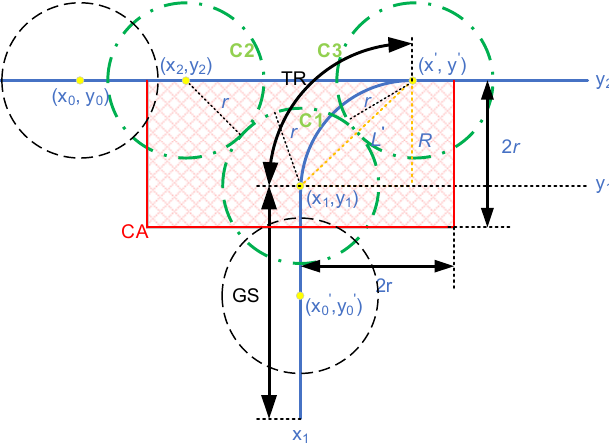
Figure 6. Vehicle body circles C1, C2, and C3 at the critical position.